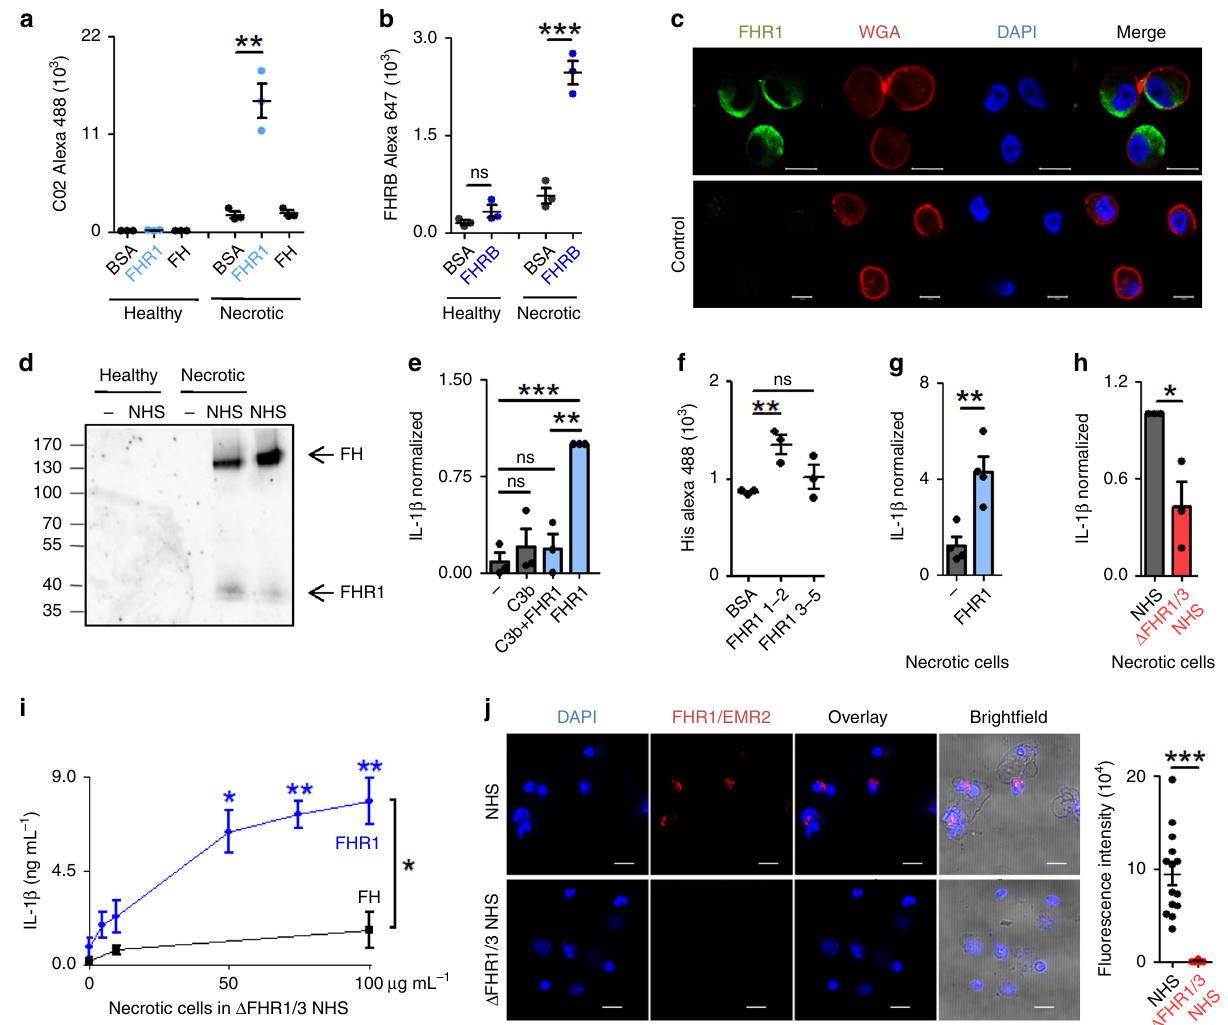
Fig. 5 FHR1 binds to necrotic cells and triggers IL-1 β release by monocytes. a , FHR1, but not FH binds necrotic HUVECs, as shown by fl ow cytometry. b FHRB binds to necrotic but not healthy mouse alveolar macrophages, FHRB antiserum was used for fl ow cytometry. c FHR1 (green) binds to necrotic cells. DNA (blue) is stained with DAPI and membrane (red) with WGA. Scale = 10 µ m. d FHR1 and FH from NHS bind to necrotic, but not to healthy cells. One representative western blot of three is shown. e FHR1 bound to C3b does not induce IL-1 β release by monocytes. f FHR1 SCR1 – 2 binds to necrotic HUVECs. g FHR1 bound to necrotic HUVECs triggers IL 1 β in monocytes. h IL-1 β release in response to necrotic HUVECs is reduced in Δ FHR1/3 NHS compared to NHS. i Reconstitution of FHR1 in Δ FHR1/3 NHS increased IL-1 β release by monocytes. FH has no effect. j Complexes (red) of FHR1 (on necrotic cells) with EMR2 receptor (on monocytes) in whole blood. Total picture fl uorescence intensity of single cells ( n = 14 for FHR1/3, n = 10 for Δ FHR1/3) were analyzed using unpaired two-tailed t-test. Data in a – i represent the mean ± SEM of three to four independent experiments with